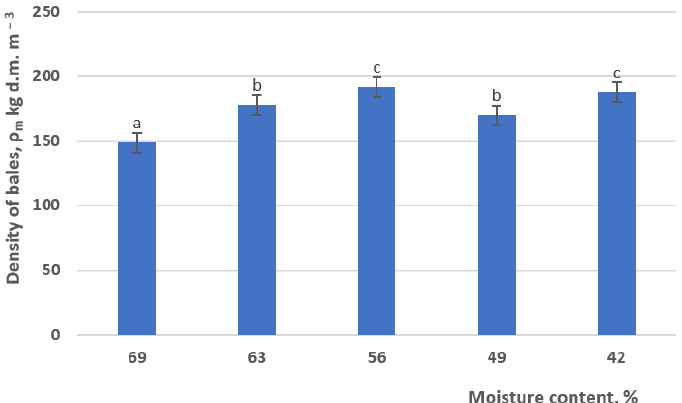
Figure 5. Bar chart of balage density in bales at different moisture content levels at a pressing pressure of 9 MPa and plant material at a length of 312 mm. Different lowercase letters indicate a statistically significant difference at p ≤ 0.05. d.m., dry matter.